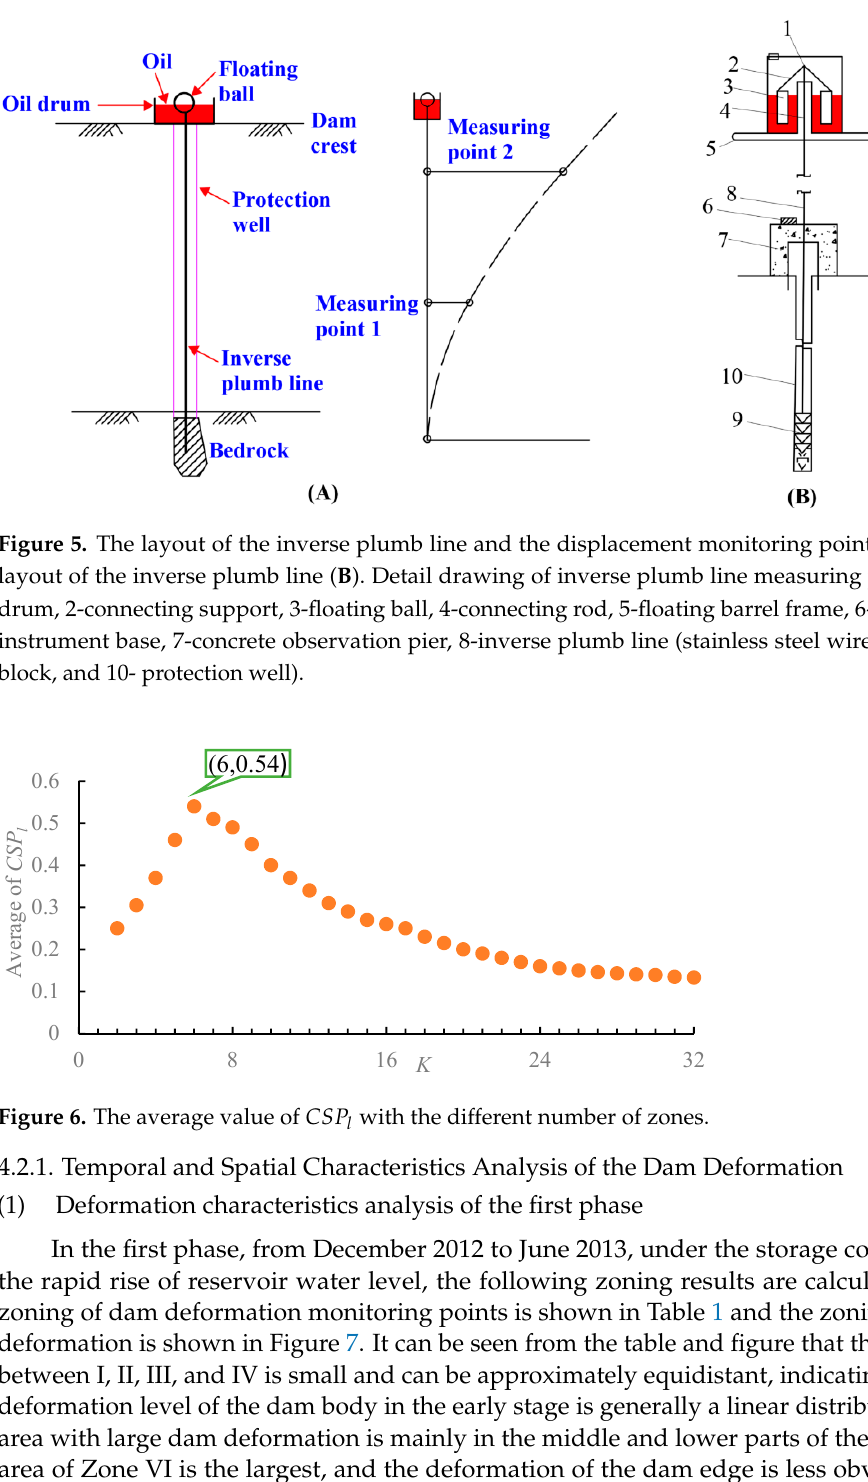
Figure 6. The average value of l